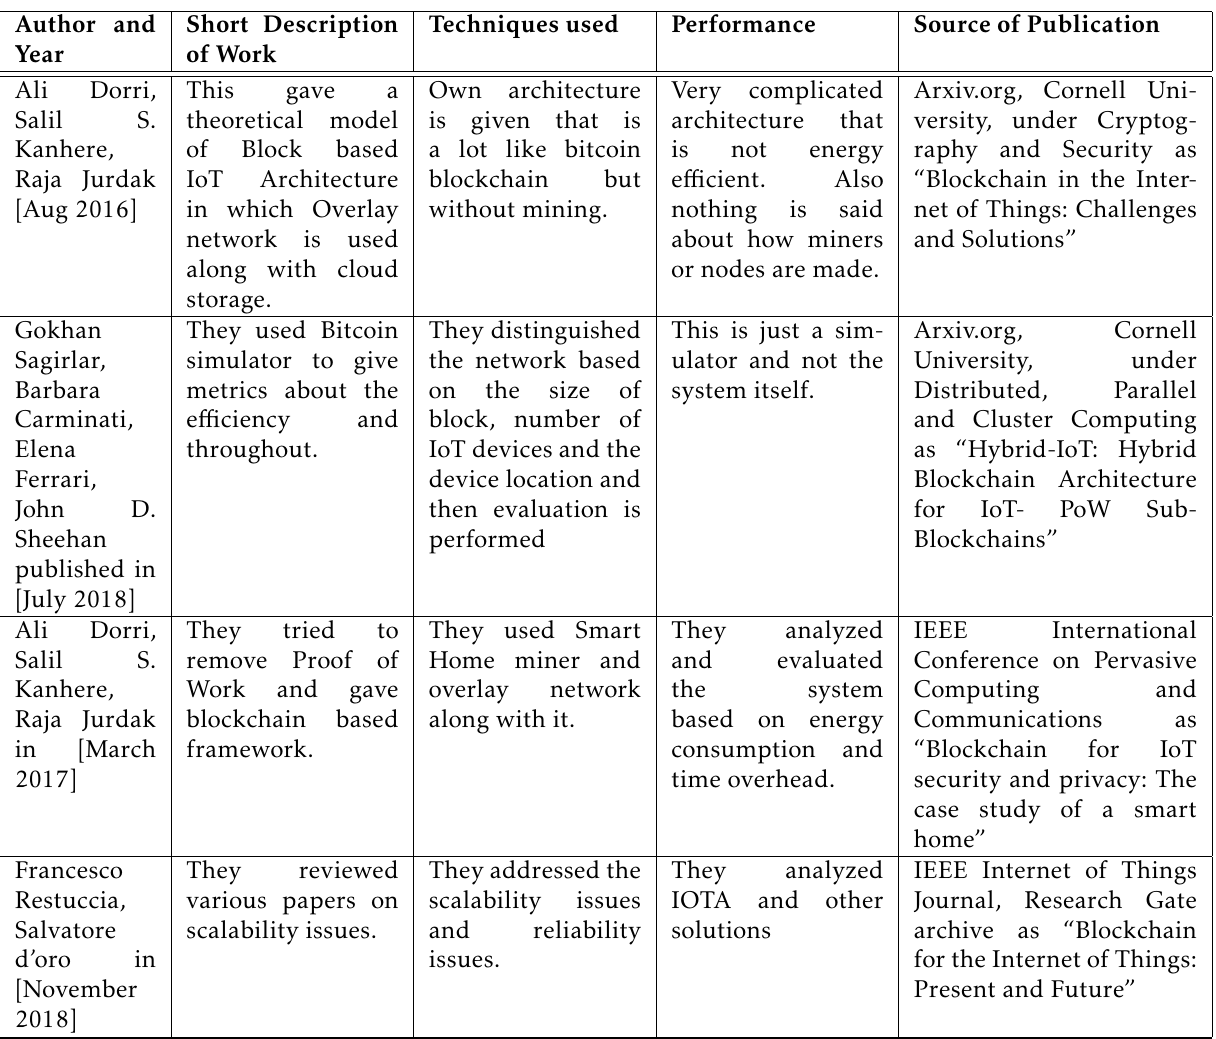
Table 1. Analysis of Related Papers in this